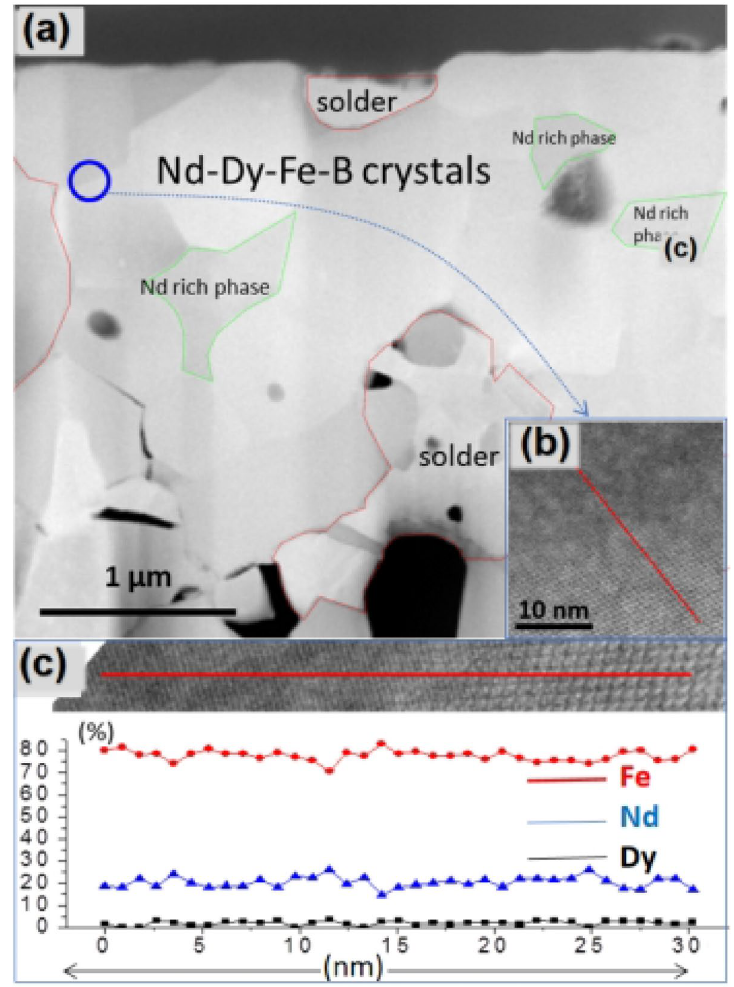
Figure 2. ( a ) LAADF-STEM image of Nd 1.5 Dy 0.5 Fe 14 B, ( b ) HAADF-STEM image and corresponding EDS line profile taken from blue circle in ( a ). ( c ) EDS line profile of ( b